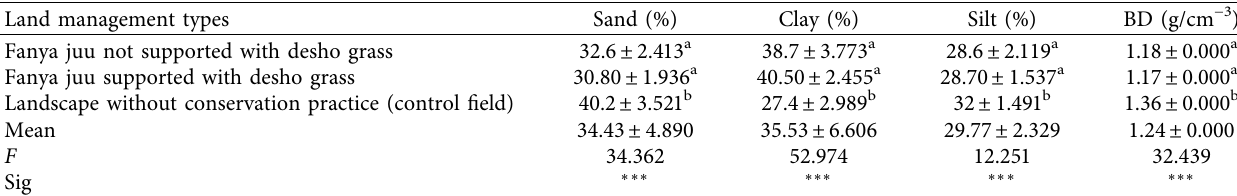
Table 1: Efects of land management on soil physical properties (mean ± standard deviations). Land management